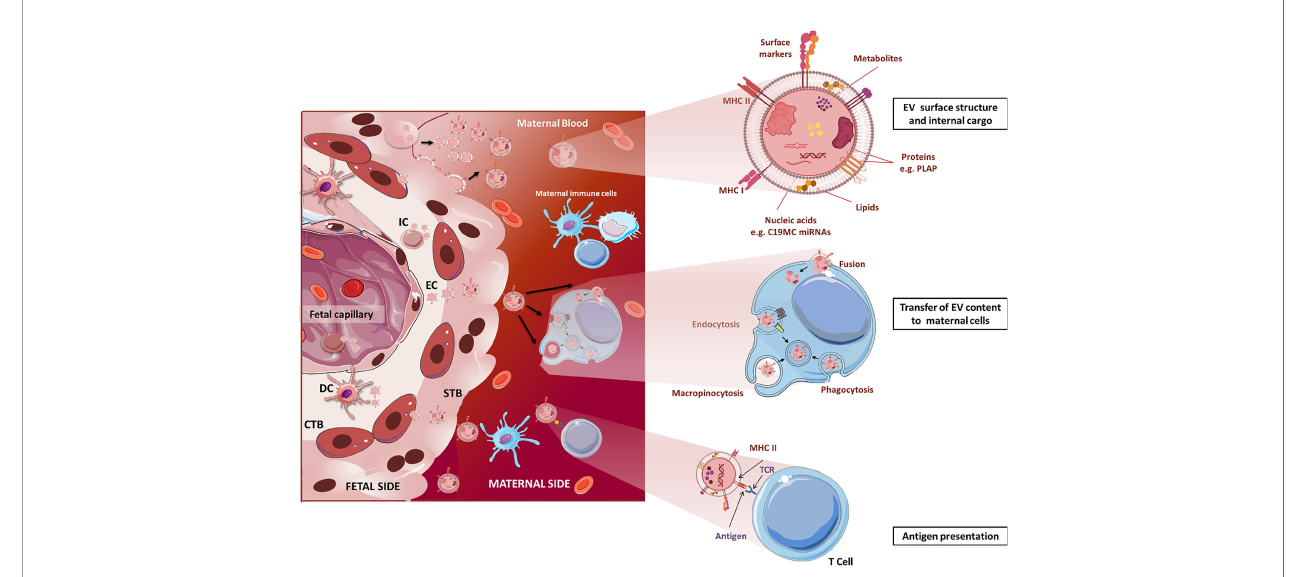
FIGURE 1 | Structure and immunological functions of fetal EVs in pregnancy. Fetal cells, including endothelial, immune, dendritic, and CTB cells, and especially STB, release great amounts of EVs to the maternal circulation. Upper: EV surface and internal cargo. Middle: Fetal EVs transfer their cargo to maternal immune cells by different mechanisms including endocytosis, phagocytosis and membrane fusion. Lower: EVs can act as APCs directly interacting with maternal T cells and trigger immunotolerance or activation. STB, syncytiotrophoblast; CTB, cytotrophoblast; IC, immune cell; EC, endothelial cells; DC, dendritic cells. For the sake of clear illustration, the size of structures is not displayed in realistic proportions. The fi gure was drawn using pictures from 105